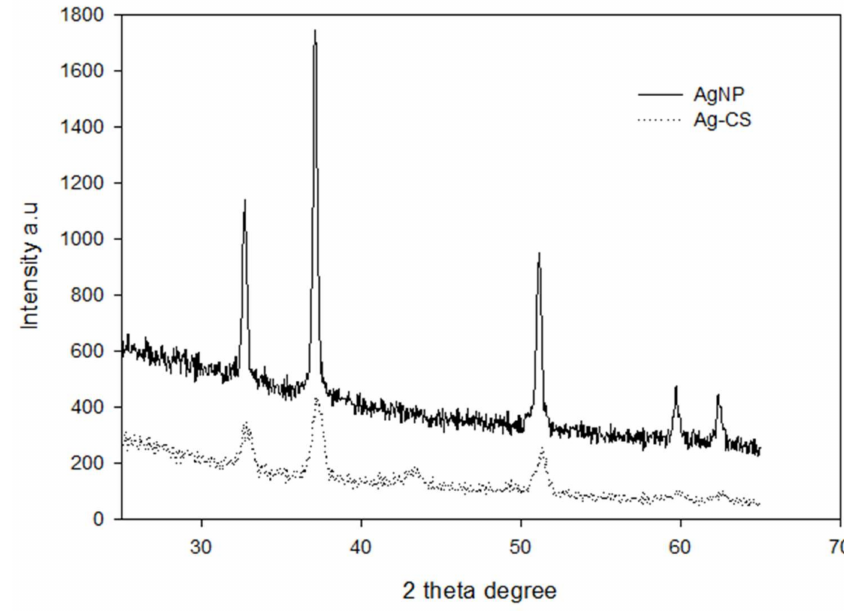
Figure 4. XRD pattern of biosynthesized AgNPs and